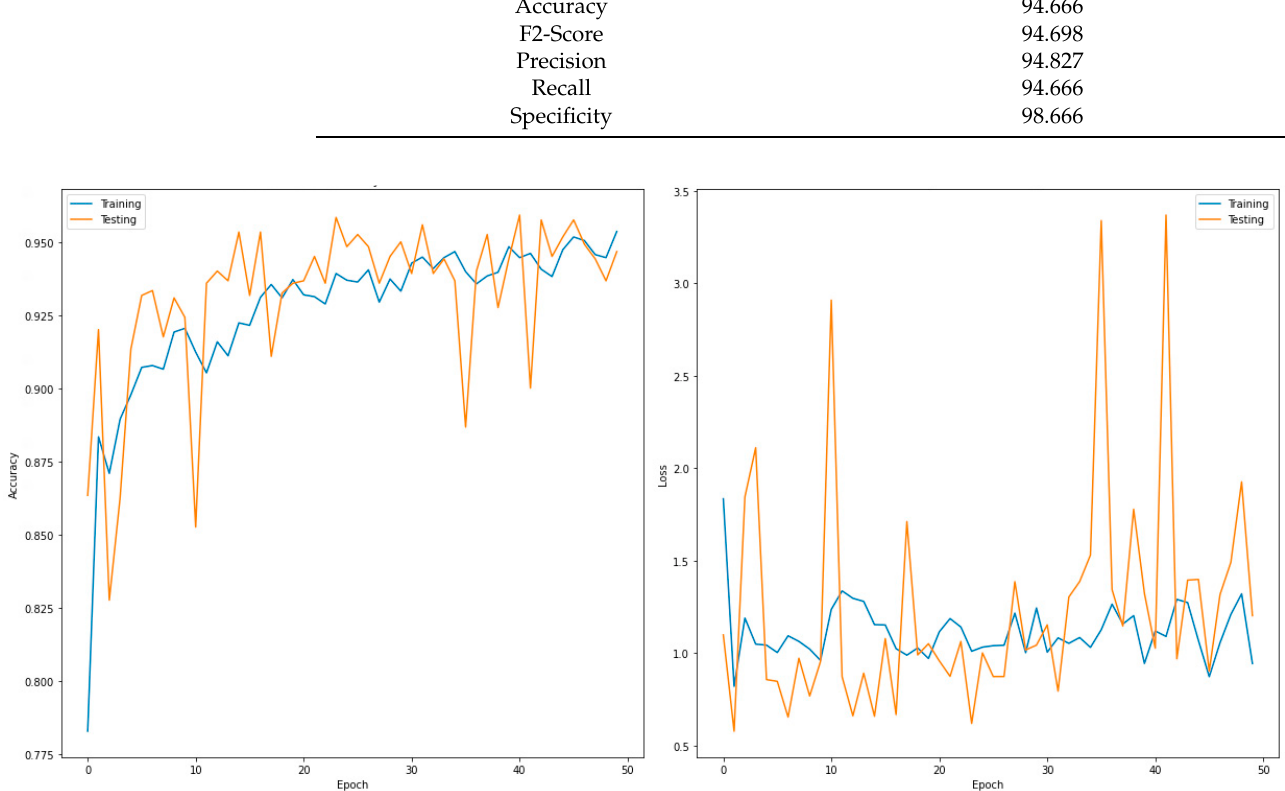
Figure 6. Accuracy ( left ) and loss curves ( right ) of DenseNet169 for five-class classifier.